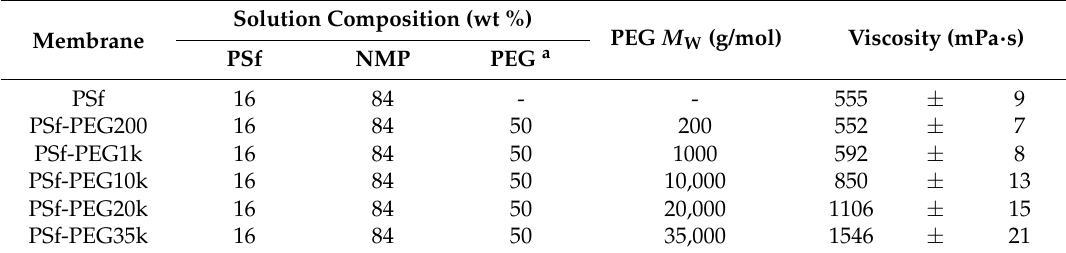
Table 1. Composition and viscosity of casting